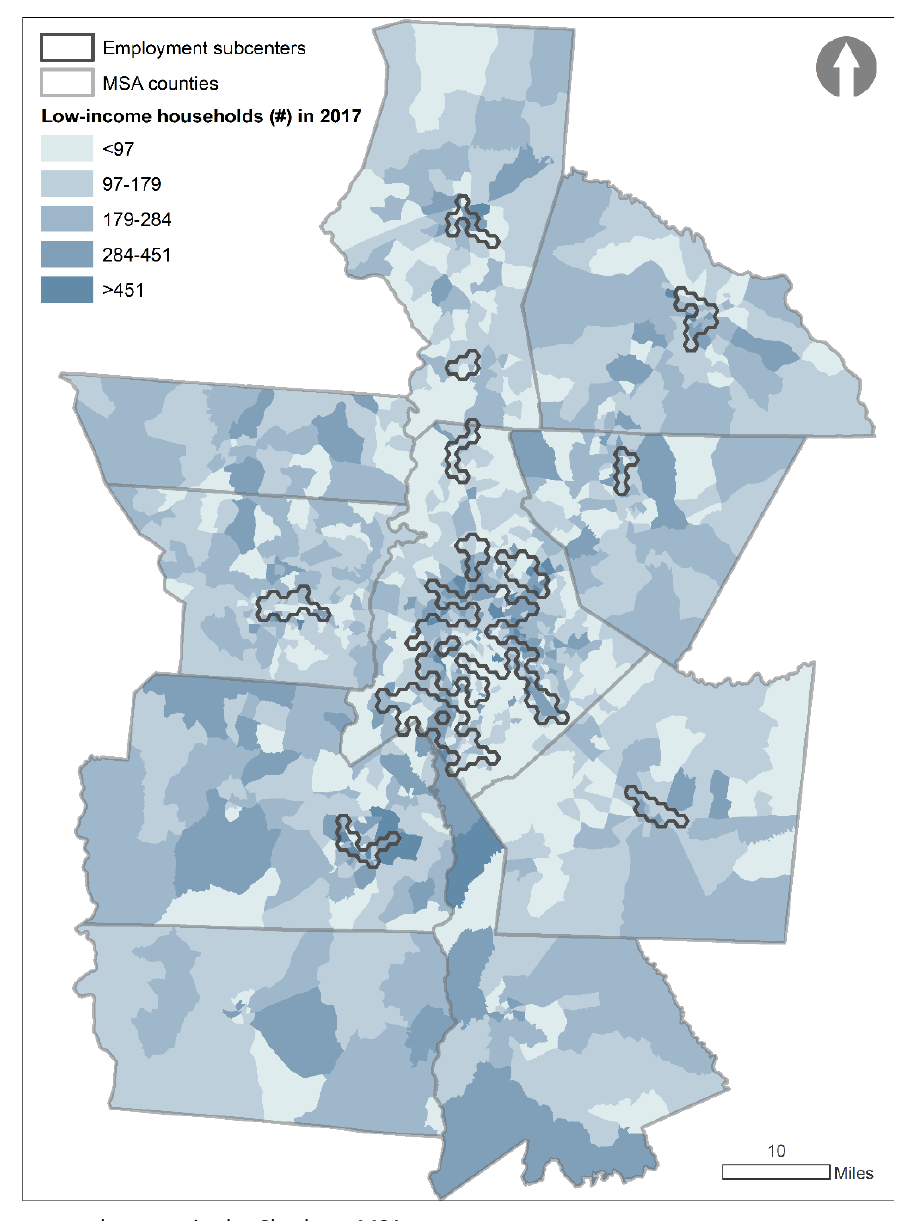
Figure 3. Employment subcenters in the Charlotte